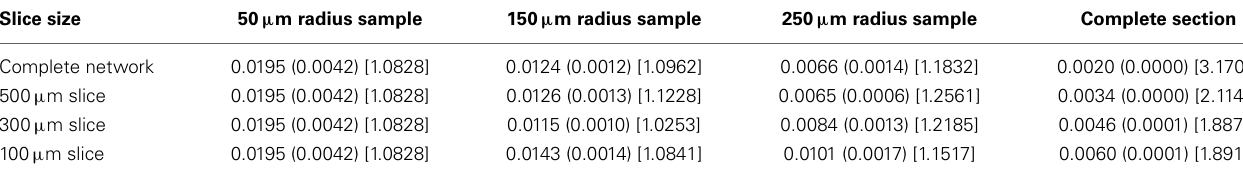
Table 2 | Bidirectional connection fraction (standard error) [fraction of chance – Erd˝os-Rényi control]. Slice